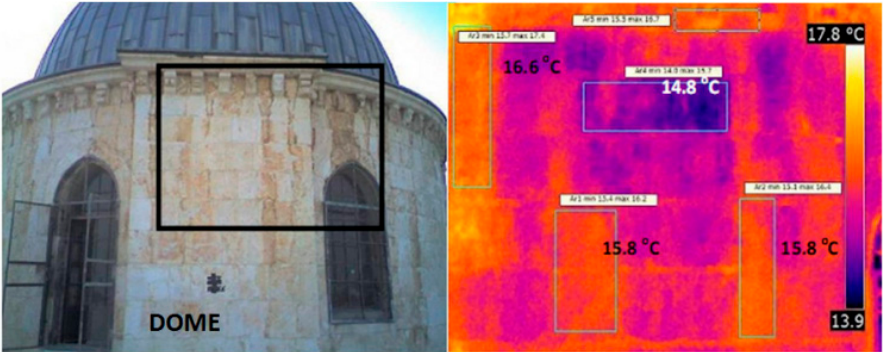
Figure 13. Dome of Katholiko in Holy Selphuchre Temple, area of investigation and corresponded thermogram.